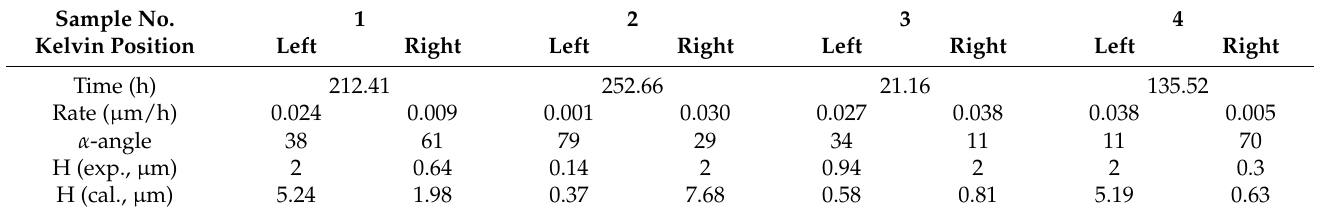
Table 2. Comparison of theoretical and actual depletion rates of Ni UBM at low current